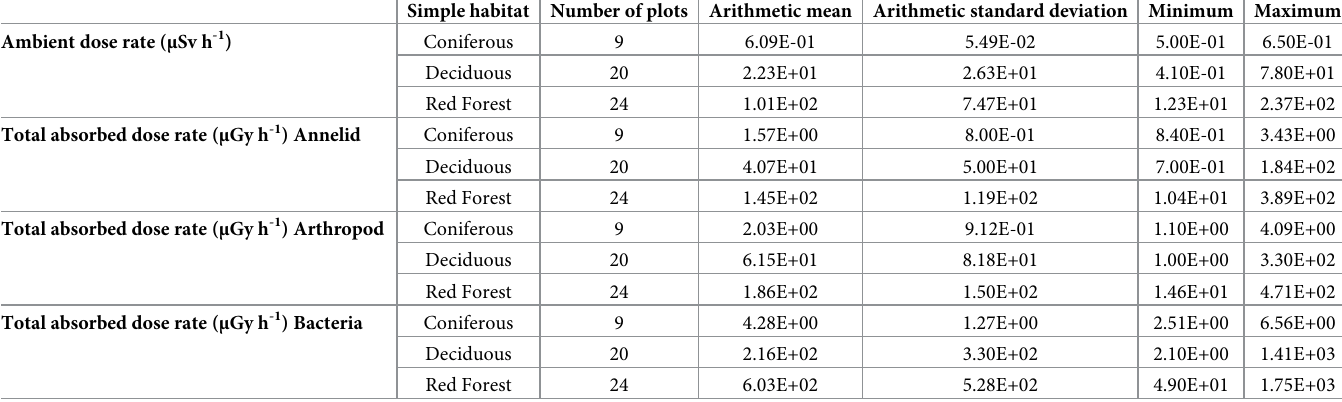
Table 2. Measured ambient dose rate at the soil surface and estimated total weighted absorbed dose rate to selected relevant reference organisms summarised by simple habitat type. Simple habitat Number of plots Arithmetic mean Arithmetic standard deviation Minimum